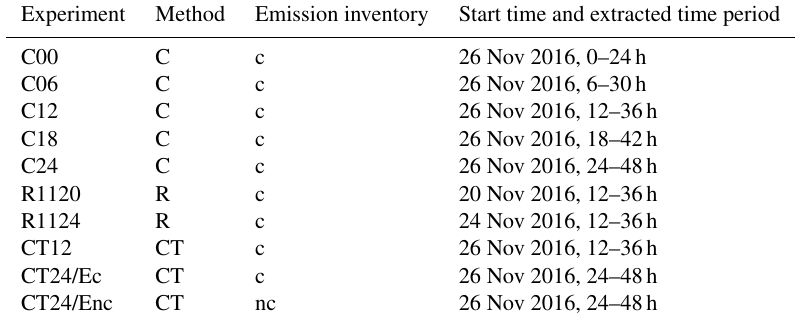
Table 3. The simulation experiment configurations. C00–C24, R1120, R1124, CT12, and CT24 were used to investigate the impact of simulation methods, the start time, and the extracted time period. The impact of different emission inventories was investigated using Ec and Enc. C, R, and CT in the “Method” column represent the clean initial condition simulation methods, the restart simulation, and the continuous simulation; nc and c in the “Emission inventory” column represent the original emission inventory and the updated local emission inventory with the construction fugitive dust emissions